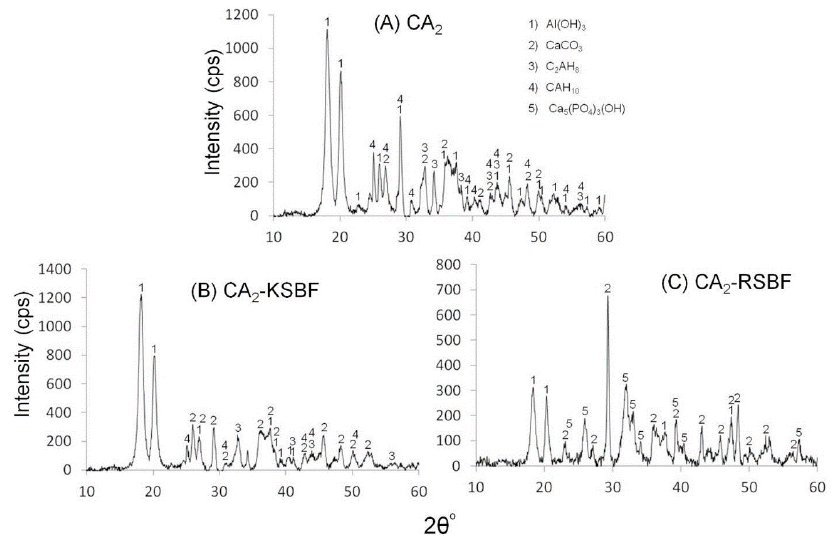
Figure 6. XRD patterns of CA (A) before immersion in SBF; (B) after 7 days in KSBF and (C) after 7 days in RSBF. 2